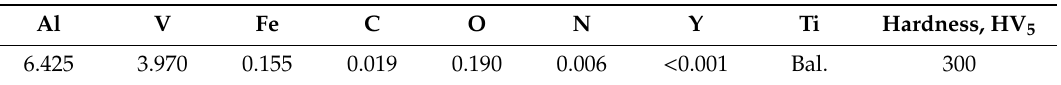
Table 2. Hardness and chemical composition (weight %) of the Ti6Al4V according to according to the material specification provided by material supplier Timet.